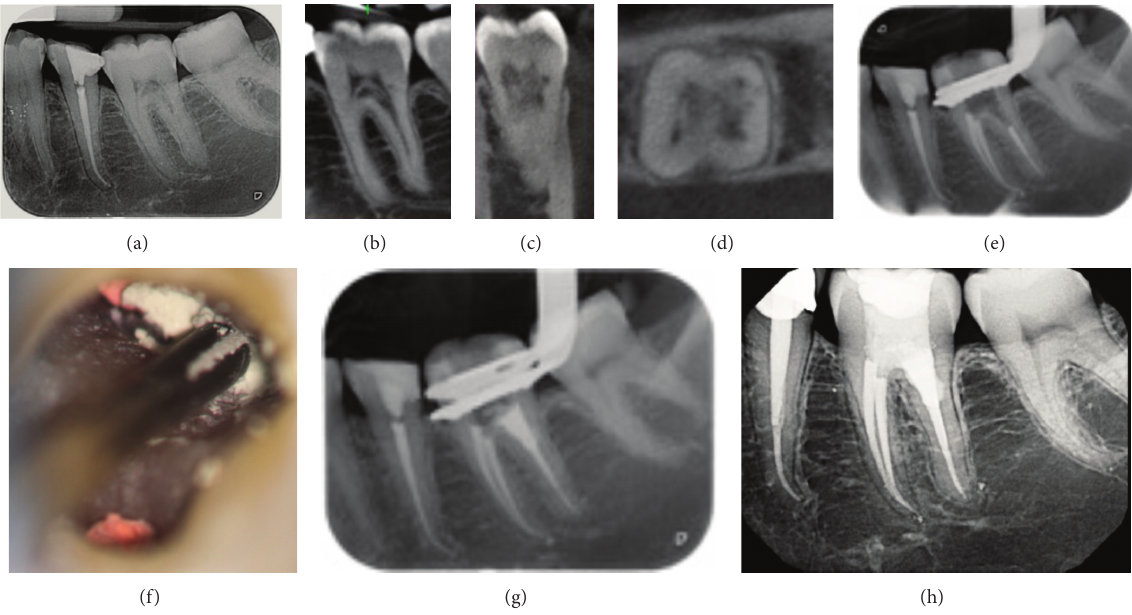
Figure 4: Management of internal replacement root resorption with root perforation, using both warm gutta-percha and MTA for root canal filling (tooth 36). (a) Preoperative intraoral radiograph of the first left lower molar showing an enlargement associated with a fuzzy appearance of pulp chamber and the first third of the root canal. (b), (c), and (d) Sagittal, coronal, and axial CBCT cross-sections confirm the enlargement of pulp space and the abnormal apposition of dentin/bone-like hard tissue. (e) After chemomechanical and ultrasonic removal of pathological soft and hard tissues, the mesial canals and the 2/3rd of the distal root were filled with warm compacted gutta percha, leaving free the resorbed area. (f) Peroperative clinical view of the MTA material placed in the resorbed area and (g) the immediate X-ray to assess the quality of the root canal obturation. (h) Periapical X-ray: control of treatment at one year. Note the absence of periapical disease and the healthy appearance of the furcation facing the resorbed area filled with MTA.